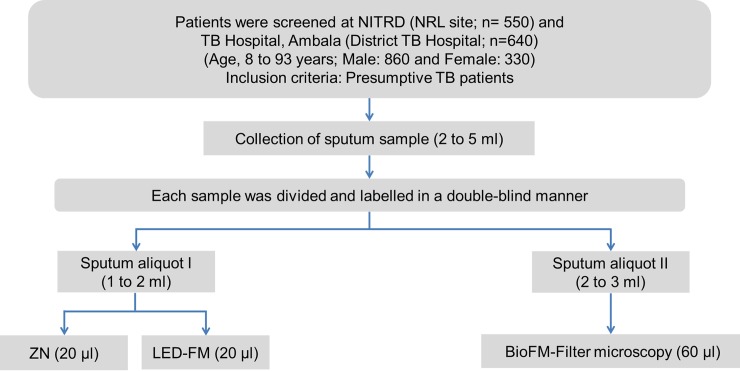
Workflow of the ‘TB detect’ kit evaluation study.